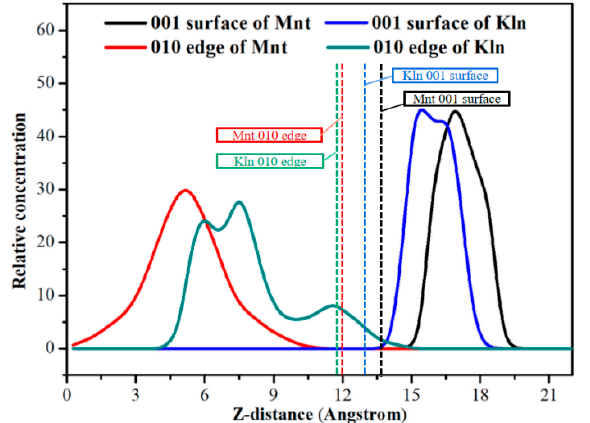
Figure 6. Relative concentration profiles of saturates molecules in surfaces and edges of Mnt and Kln along the Z -axis at 298 K.